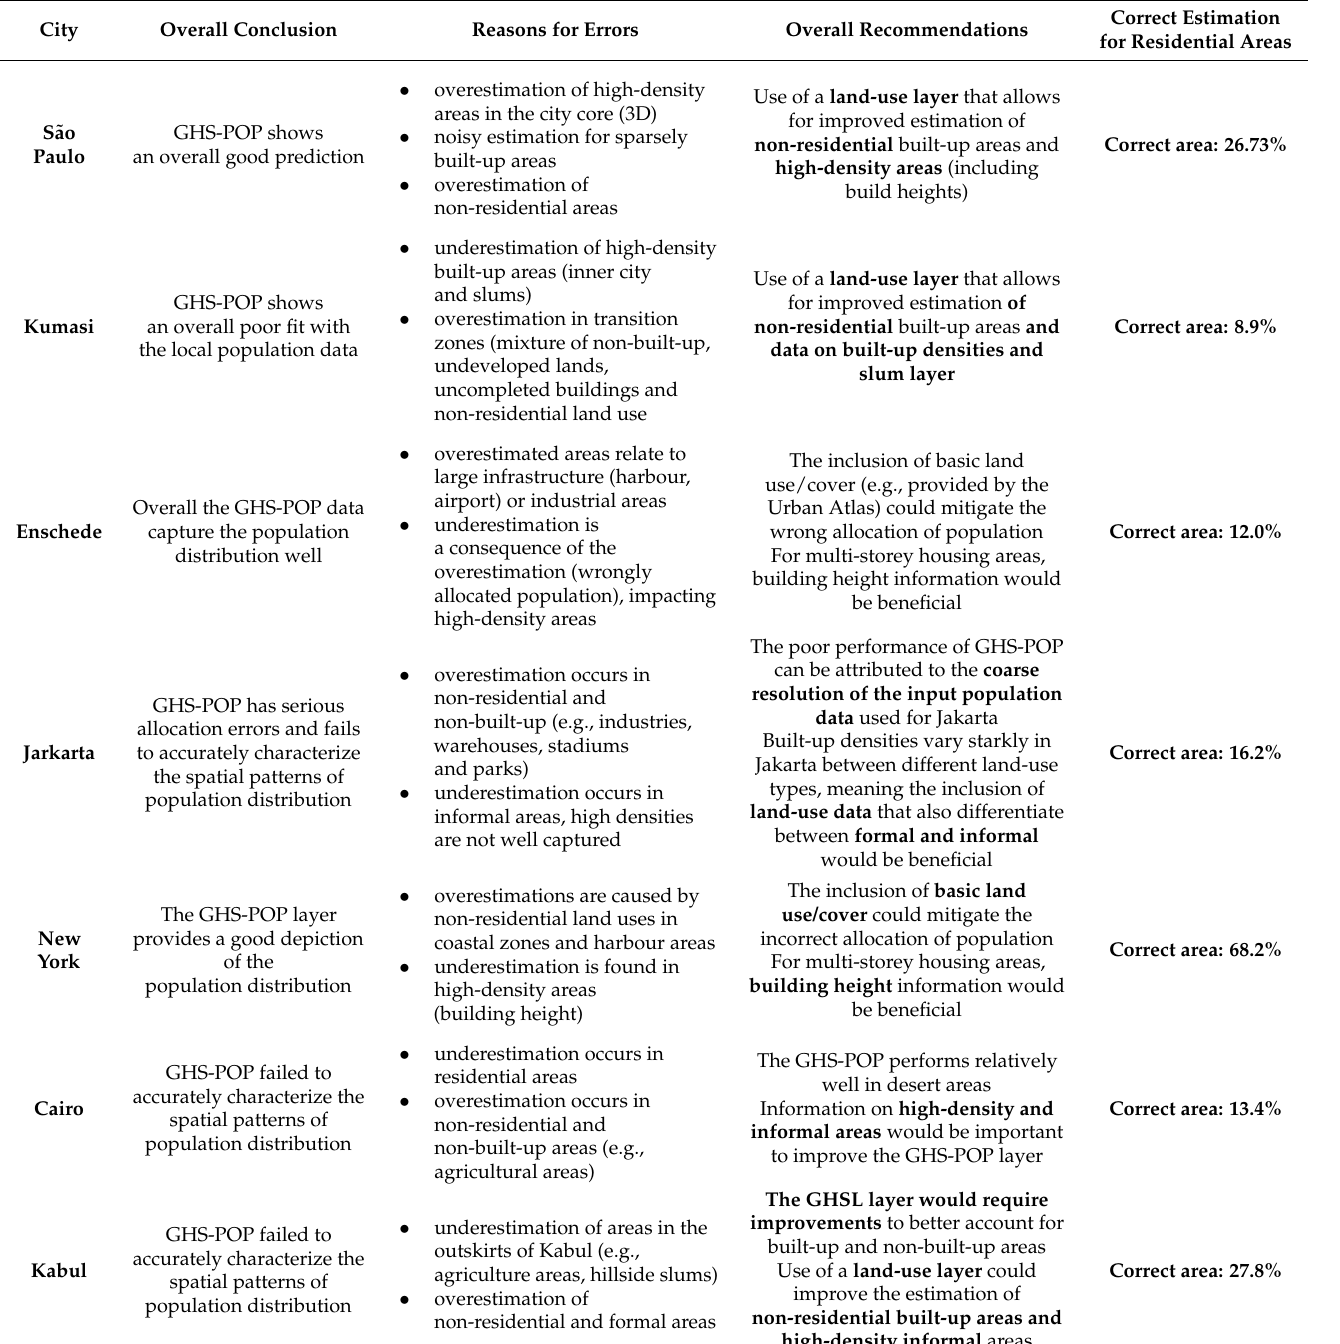
Table 7. City comparison between GHS-POP and local population